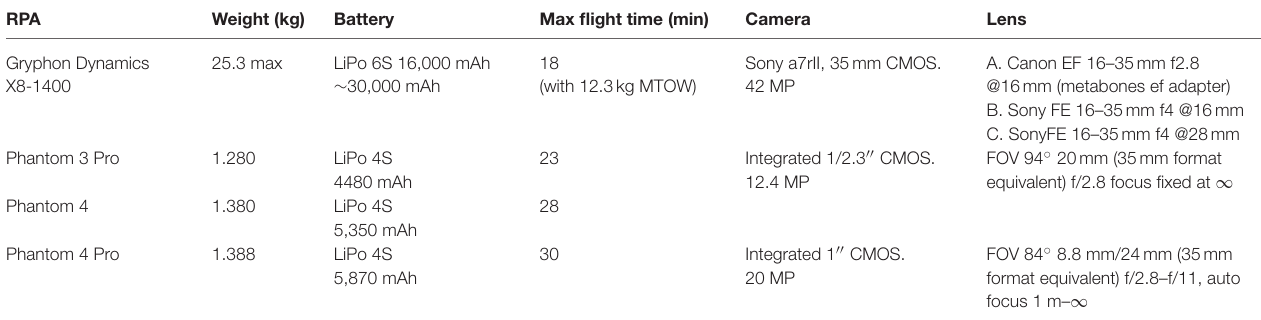
TABLE 1 | Details of Remote Piloted Aircraft (RPA) systems used for the